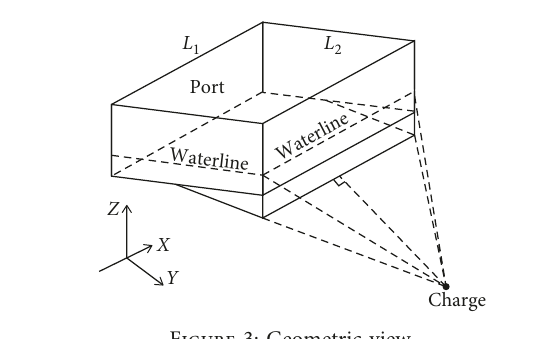
Figure 3: Geometric view.